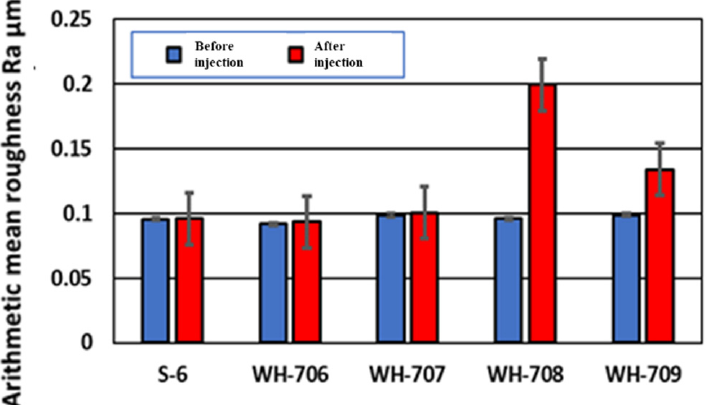
Figure 11. The arithmetic mean roughness Ra of the test piece surface for each simulated stain is shown.